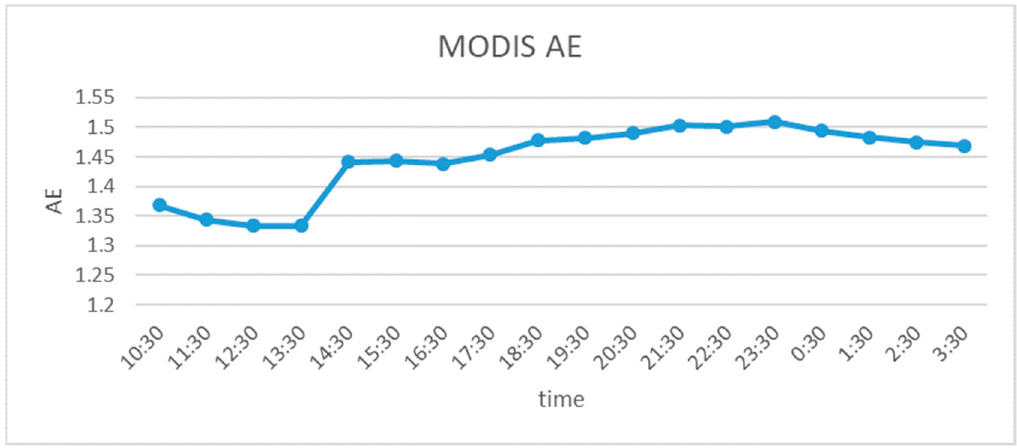
Figure 8. June 29 AE over time in Nanjing.